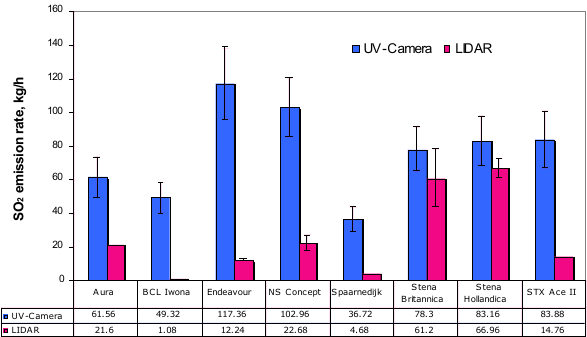
Figure 8. Comparison of LIDAR and UV-camera measurements of the same ships taken at same time and location on the 17 September.